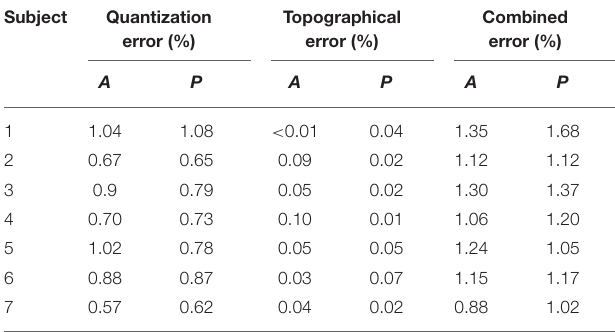
TABLE 1 | Quantization, topographical and combined errors after training with SOFMs per subject per ROI (A: anterior musculature; P: posterior musculature).